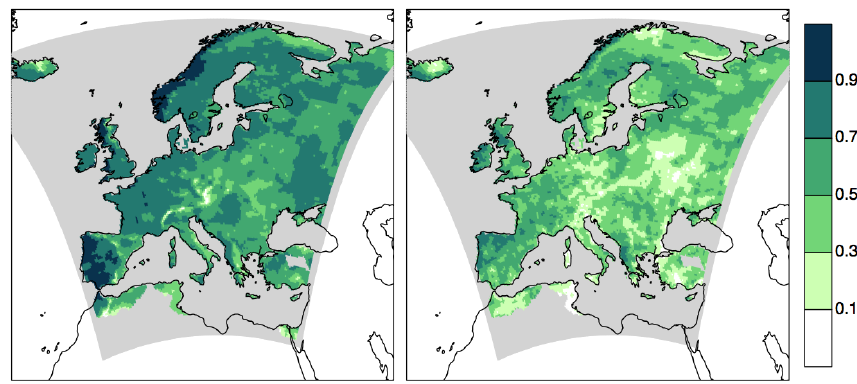
Figure 1. Local representativeness. Correlation between local (at the same grid box) simulated and observed seasonal mean time series. Left panel: DJF; right panel: JJA. Under the assumption of independence, correlations C k > 0.3 are pointwise statistically significant at the 95%